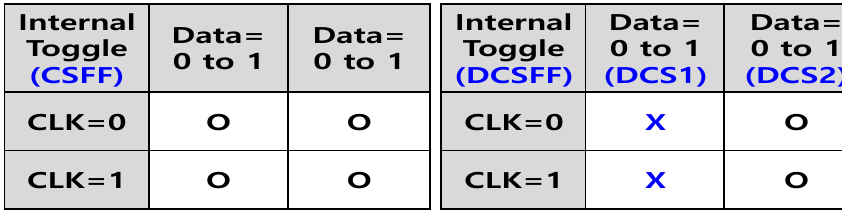
Figure 7. Comparison of Internal Toggle Transitions between DCSFF and CSFF.